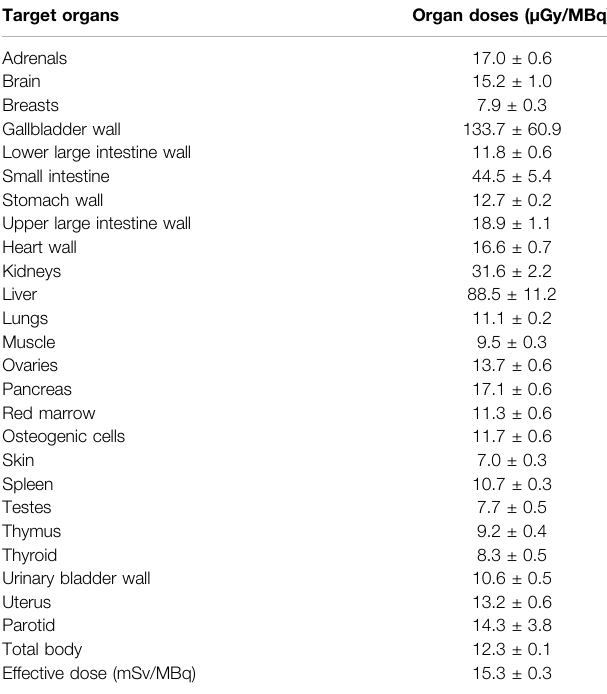
TABLE 1 | Absorbed doses to target organs and effective dose. Target